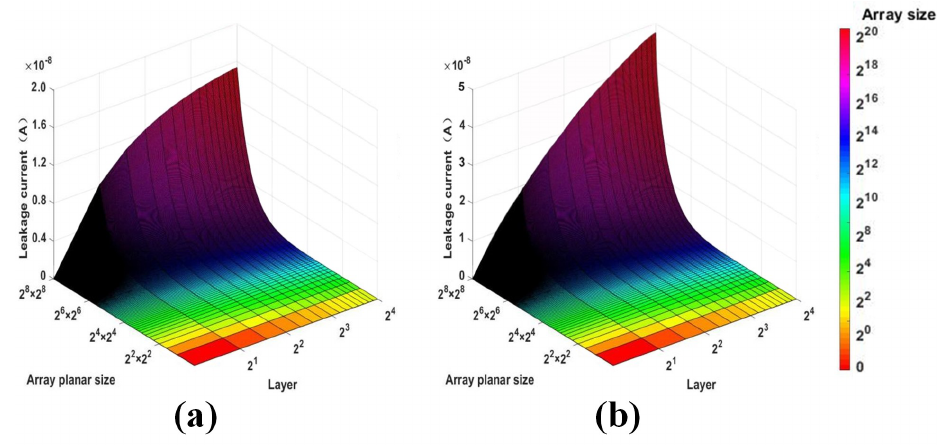
Figure 8. ( a ) Read leakage current under different array sizes and ( b ) write leakage current under different array sizes (from 4 × 4 to 256 × 256 and 1~16